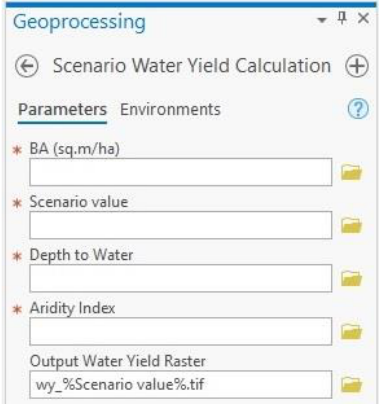
Figure A5. The geoprocessing window when using the Current Water Yield Calculation tool.